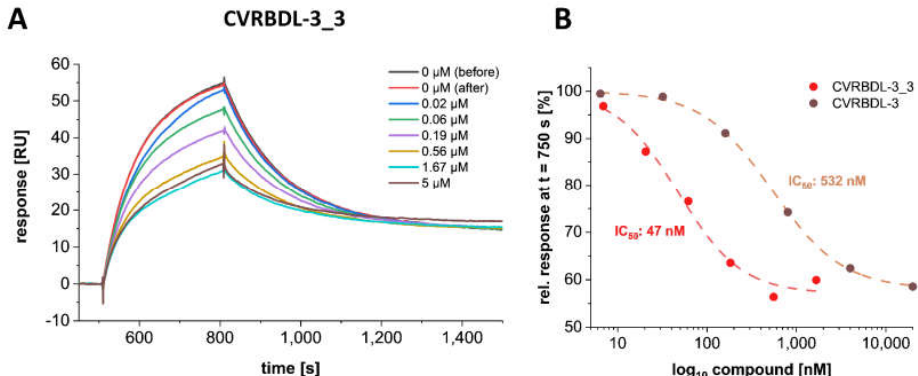
Figure 10. CVRBDL-3_3 much more efficiently inhibits the SARS-CoV-2 S1S2 spike protein interaction with hACE2 as compared to CVRBDL-3. ( A ) hACE2-fc was immobilized on a Protein A/G- derivatized sensor surface in a T200 SPR device (Cytiva, USA). 50 nM SARS-CoV-2 S1S2 was injected with or without 6.4 nM to 100 µM CVRBDL-3_3. Injections without compound were performed prior and after the concentration row to verify reproducibility of the S1S2 binding level. All injections with compound and spike protein were referenced with the corresponding concentration of compound only injections on the hACE2 immobilized surface. Injections were performed with 30 µL/min in 10 mM HEPES (pH 7.4), 150 mM NaCl, 3 mM EDTA, 0.005% ( v / v ) Tween-20. ( B ) Relative response in steady state as detected 270 s after injection start (for CVRBDL-3 see Figure 6). The inhibitory effect of CVRBDL-3 and CVRBDL-3_3 saturates at ~58% of the S1S2 binding level without compound. The IC 50 was determined by Boltzman sigmoidal fit to be 532 nM (OriginPro, OriginLab, USA).